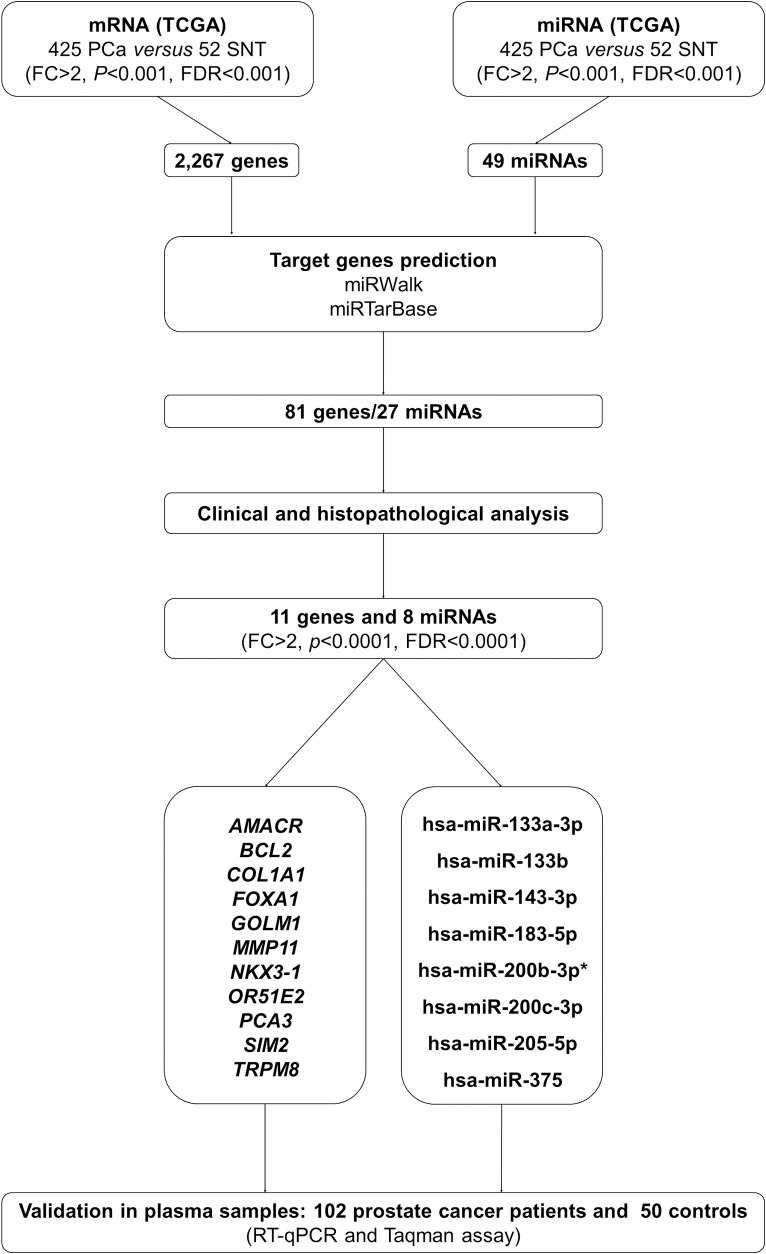
Flowchart of the analyses to define candidate genes.*Gene selected from Pubmed database.